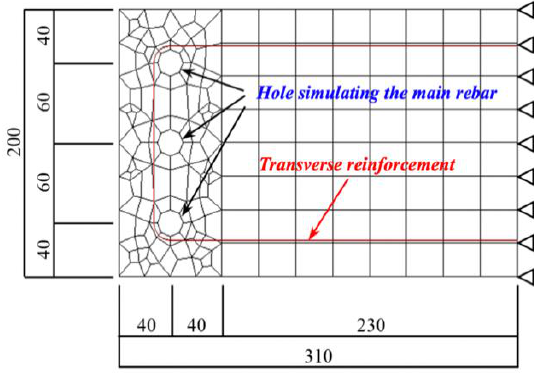
Figure 10. Numerical model and boundary conditions.